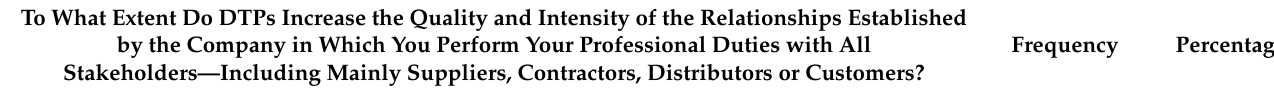
Table 5. The impact that DTPs have on relations with